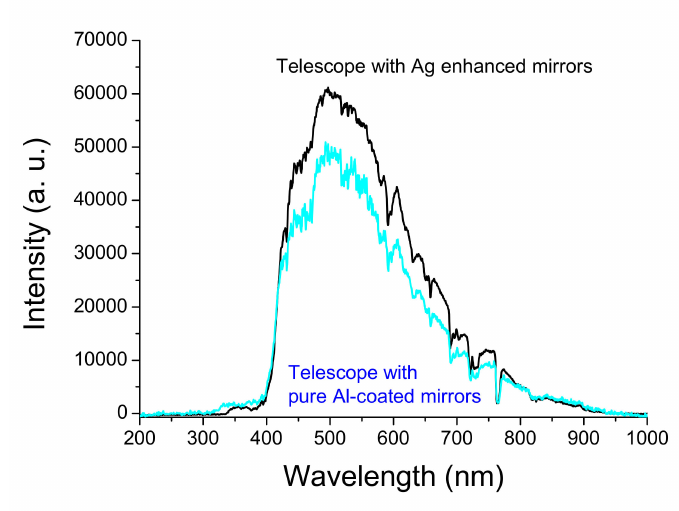
Figure 11. Spectra of two exit pupils of the double